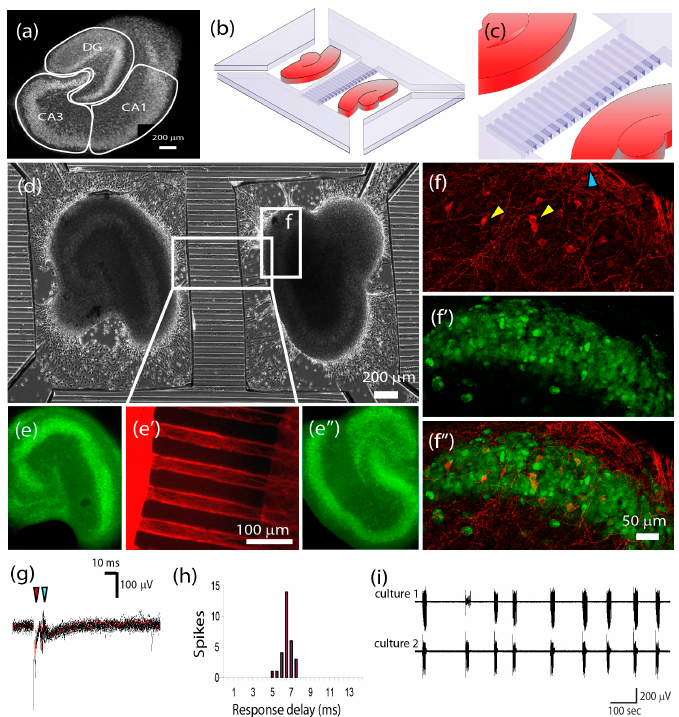
Figure 5. Pathway reconstruction using organotypic hippocampal cultures. ( a ) Single organotypic hippocampal culture. Layers containing neuronal soma appear bright in the image; ( b ) PDMS device to co-culture two organotypic hippocampal slices (slices colored red); ( c ) Microchannels connected to two PDMS wells; ( d ) Phase micrograph of the device; ( e , e” ) Cultures maintained well-organized neuronal layers, and ( e’ ) axons grew from neurons in the cultures ( f – f” ), blue arrowhead points to axons that have been sprouted by neurons (indicated by yellow arrowheads); ( g ) Electrical stimulation of one hippocampal culture (red arrowhead) resulted in an evoked response in the neighboring culture (blue arrowhead) after a propagation and synaptic delay ( h ); ( i ) Spontaneous bursts in two axonally-linked cultures became synchronized after 14 DIV. (Reproduced by permission of The Royal Society of Chemistry [73]).